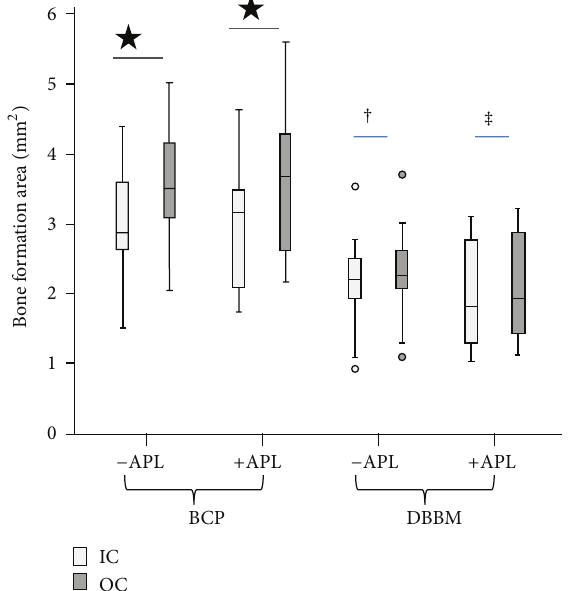
Figure5:Boxplotshowingboneformationdistributionthroughout the defect at 6 weeks after implantation. For the two filling materials, the bone surface areas in the outer zone (OC) were significantly higher than those observed in the inner zone (IC) of the defects (for BCP ∗ P < 0.0001 in the presence and absence of APL; for DBBM † P < 0.001 and ‡ P < 0.037 in the absence and presence of APL).